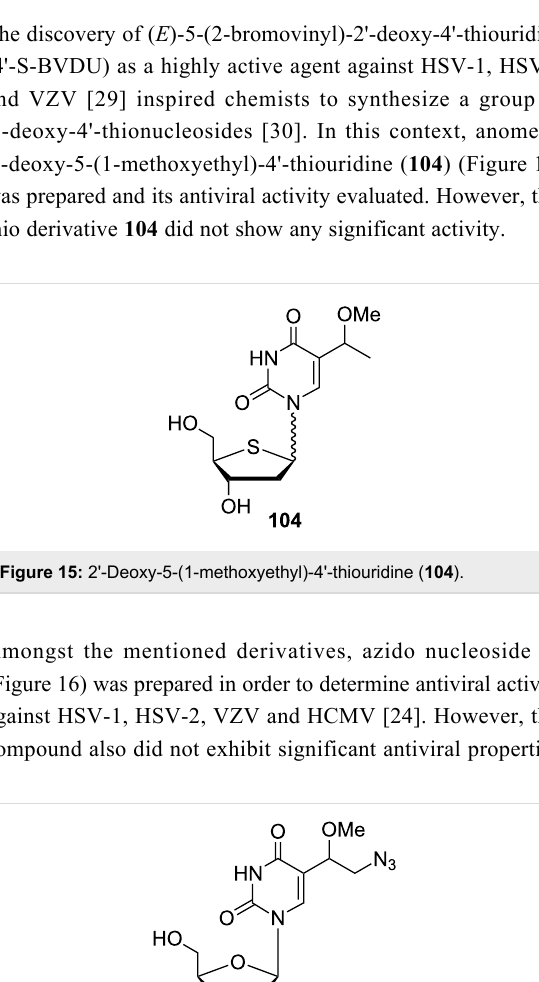
deoxyuridine (EDU) against both HSV-1 and HSV-2 but less active against HCMV than EDU and ganciclovir.